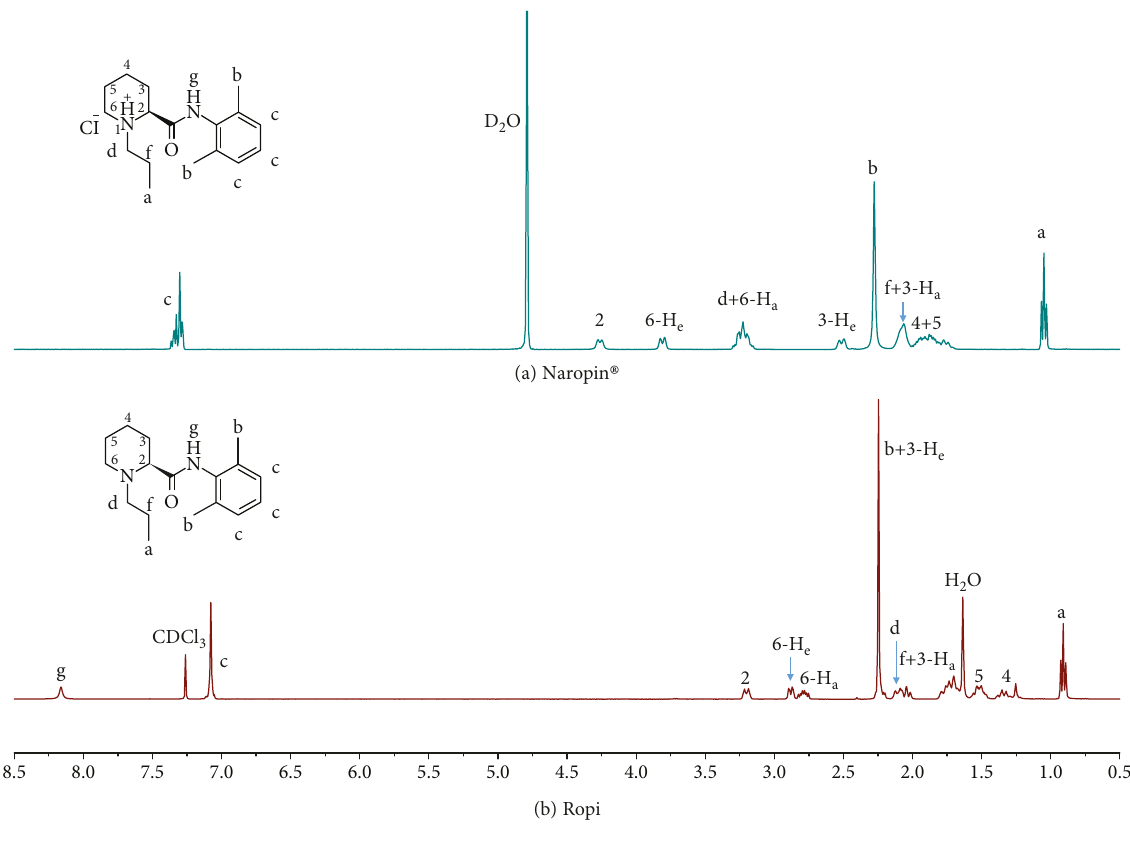
Figure 2: 1 H NMR spectra of Naropin® (a) and Ropi (b). Table 2: Optimal preparation parameters of the microspheres.